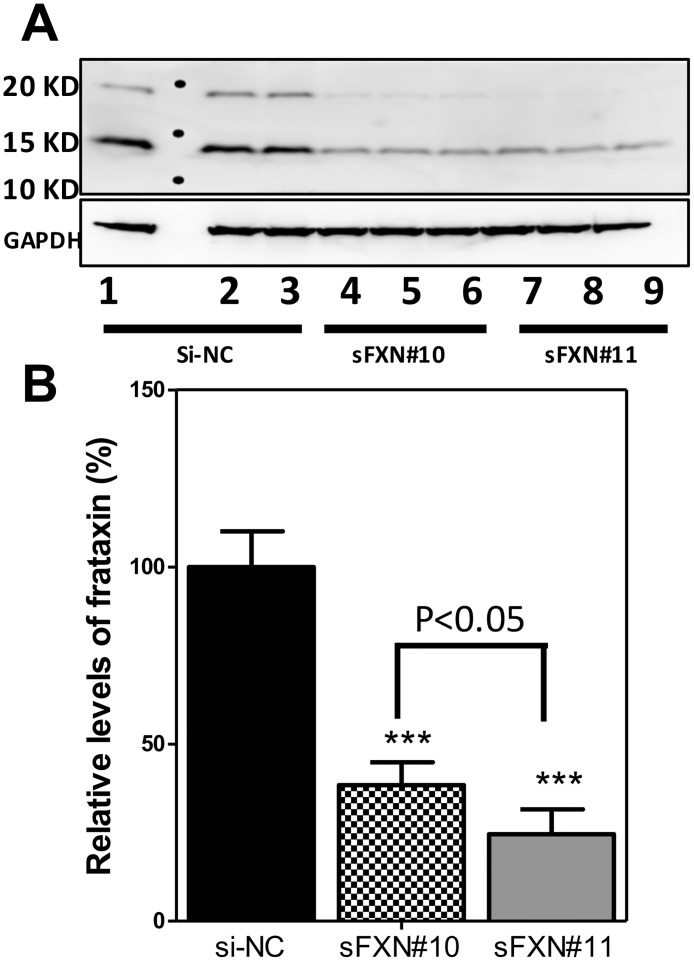
Analysis of frataxin knockdown in HepG2 cells.(A) Western blot analysis for verification of frataxin knockdown. (B) Quantitative analysis of western blots by Image J. Samples 1–3, treated with negative control siRNA (si-NC); Samples 4–6, treated with sFXN#10; Samples 7–9, treated with sFXN#11. GAPDH was used as a loading control. ***P < 0.001.